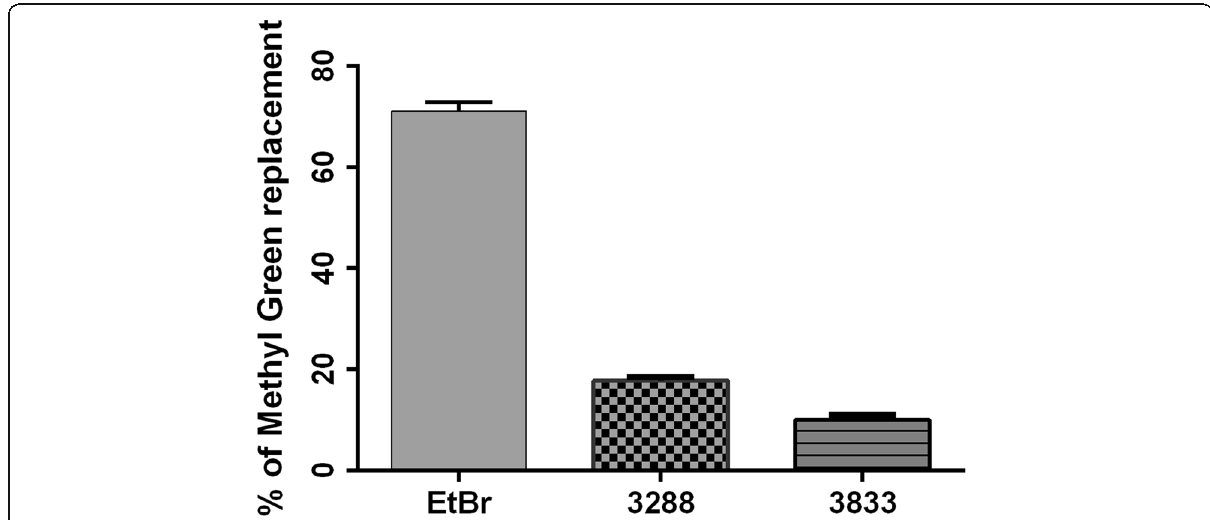
Fig. 15 Replacement of methyl green dye intercalated into the DNA of salmon sperm by Les-3288 and Les-3833 compounds (1.0 μ g/mL) and ethidium bromide (EtBr) used as a positive control